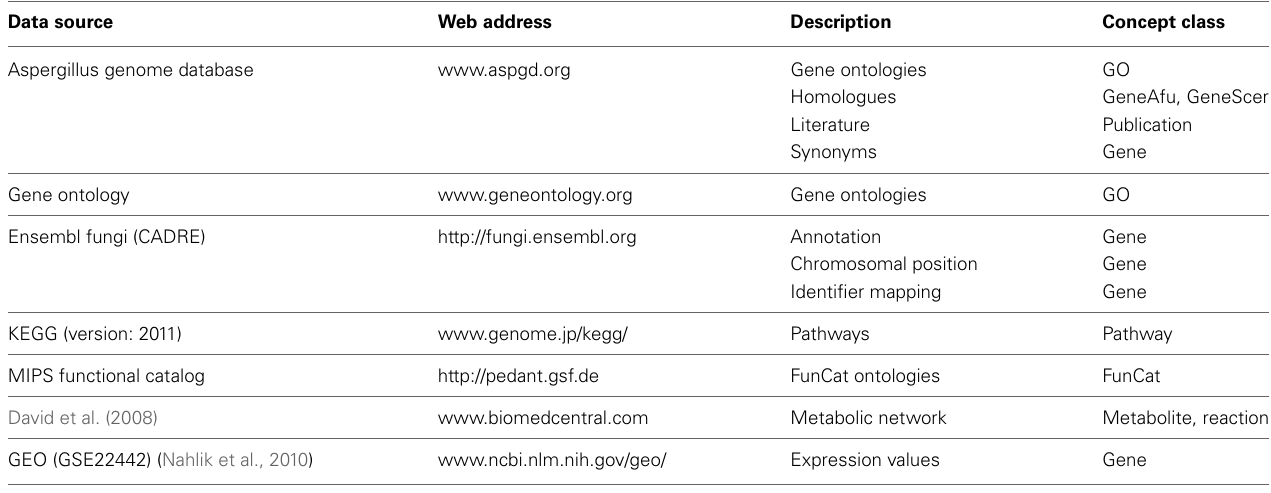
Table 1 | Data sources for A. nidulans information network.